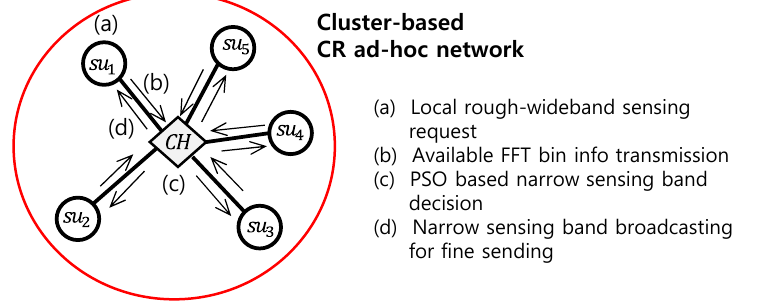
Figure 4. Wide and narrow-spectrum sensing band decision procedure.